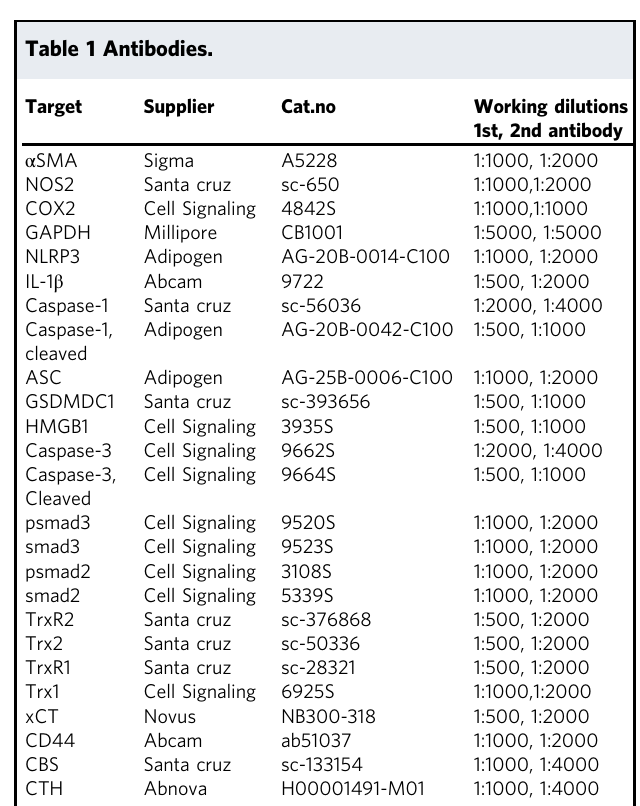
Fig. 8 System Xc is upregulated in pro fi brotic conditions and its blockade prevents activation of NLRP3 in fl ammasome. a H-score based on xCT stained IHC of liver samples from 14 normal and 64 NASH patients. Data are presented as mean ± SD, analyzed by unpaired student t -test; ** p < 0.01. b Representative images of xCT stained IHC in normal and NASH liver. Scale bar = 100 µ m. c Immuno fl uorescence images showing the localization of xCT in frozen liver sample from pro fi brotic NASH patient. Liver tissues were labeled with α SMA (green), xCT (red) and DAPI (blue). Scale bar = 20 µ m. d Slc7a11 (xCT) mRNA expression level was measured using real-time qPCR in TAA-induced fi brotic liver ( n = 8 mice per group). NS; normal saline, ND; not detected, Slc7a11 Cq value >35. e IHC images showing the localization of xCT in liver samples. Liver tissues were labeled with F4/80 and xCT. NS; normal saline, Scale bar = 200 µ m. f , g , and j Effects of erastin, sulfasalazine and cystine free media on ATP triggered IL-1 β release of LPS-primed BMDM. h , i Effects of erastin and sulfasalazine on ATP triggered IL-1 β release of LPS-primed kupffer cells. Data are presented as mean ± SD ( f , g , h , i , and j ), analyzed by one-way ANOVA followed by Tuckey ’ s test. n = 3 for f , g , j and n = 4 for h , i . *** p < 0.001, compared to control; # p < 0.05, ### p < 0.001 compared to LPS, and ATP-treated group; +++ p < 0.001, compared to LPS, and ATP-treated group in DMEM media.